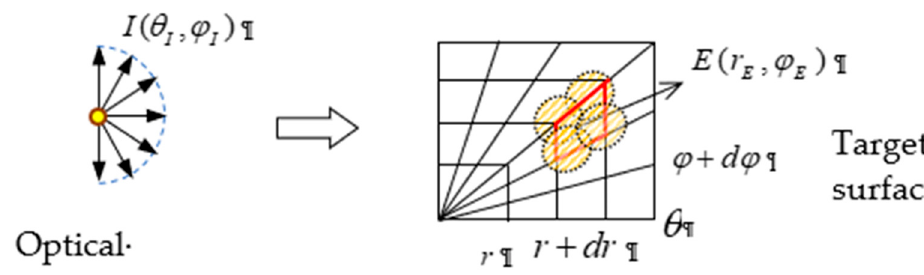
Figure 3. Ray mapping between source and target surface.